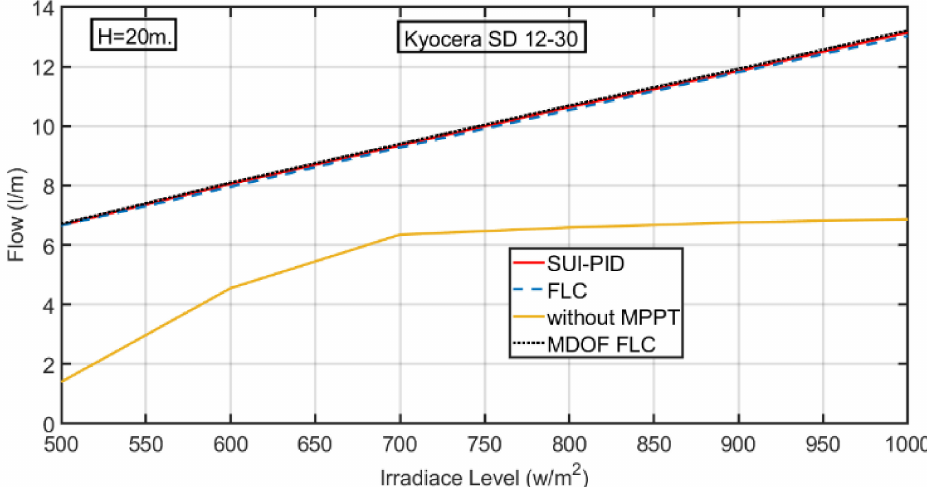
Figure 19. Performance analysis of the volume flow rate at a head of 20